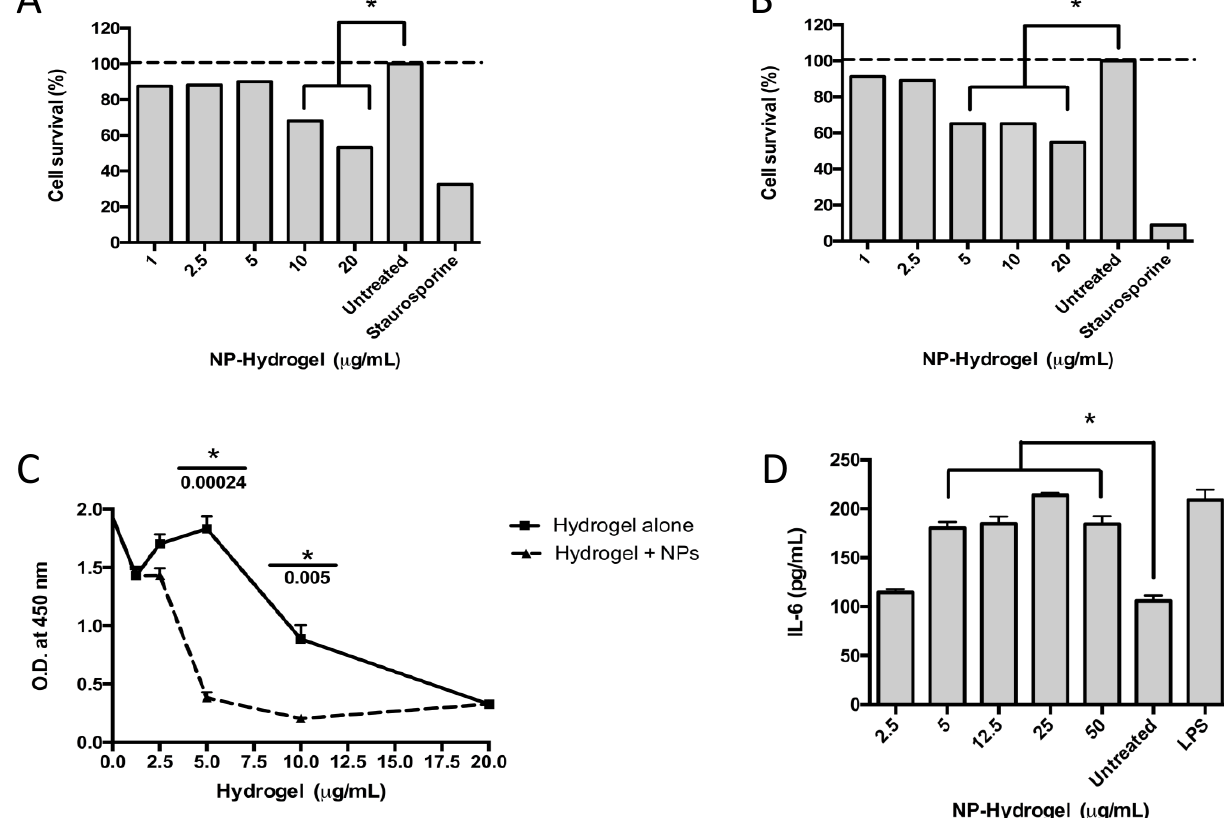
Figure 4. Effect of the colloidal chitosan dispersions on cytotoxicity and the immune response. Macrophages ( A ) and osteoblasts ( B ) were exposed to different concentrations of colloidal AgNP-Q chitosan dispersions, and the cytotoxicity was measured using the MTT assay and according to the experimental methodology. Staurosporine was used as a positive control, whereas untreated cells were used as a negative control. ( C ) A proliferation assay was performed in osteoblasts using the BrdU test over 48 h and according to the methodology. ( D ) An immunological response was measured using the pro-inflammatory cytokine IL-6 measured in the supernatant of the culture. LPS (lipopolysaccharide) and untreated cells were used as positive and negative controls, respectively. Colloidal NP-chitosan dispersion, colloidal AgNP-Q chitosan dispersion. All the experiments were performed in triplicate. The asterisk represents a p -value of <0.05. Data shown are the mean ± S.D.